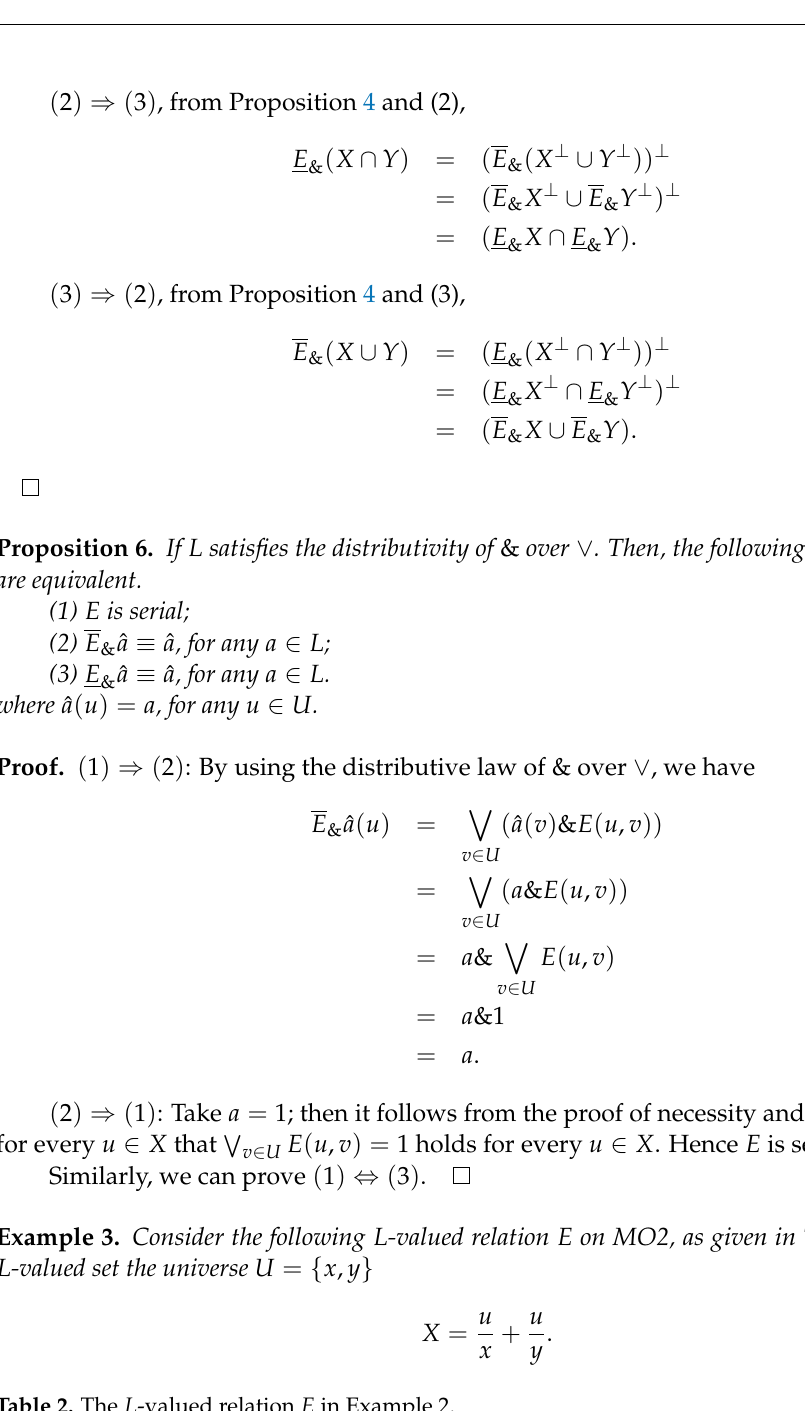
Table 2. The L -valued relation E in Example